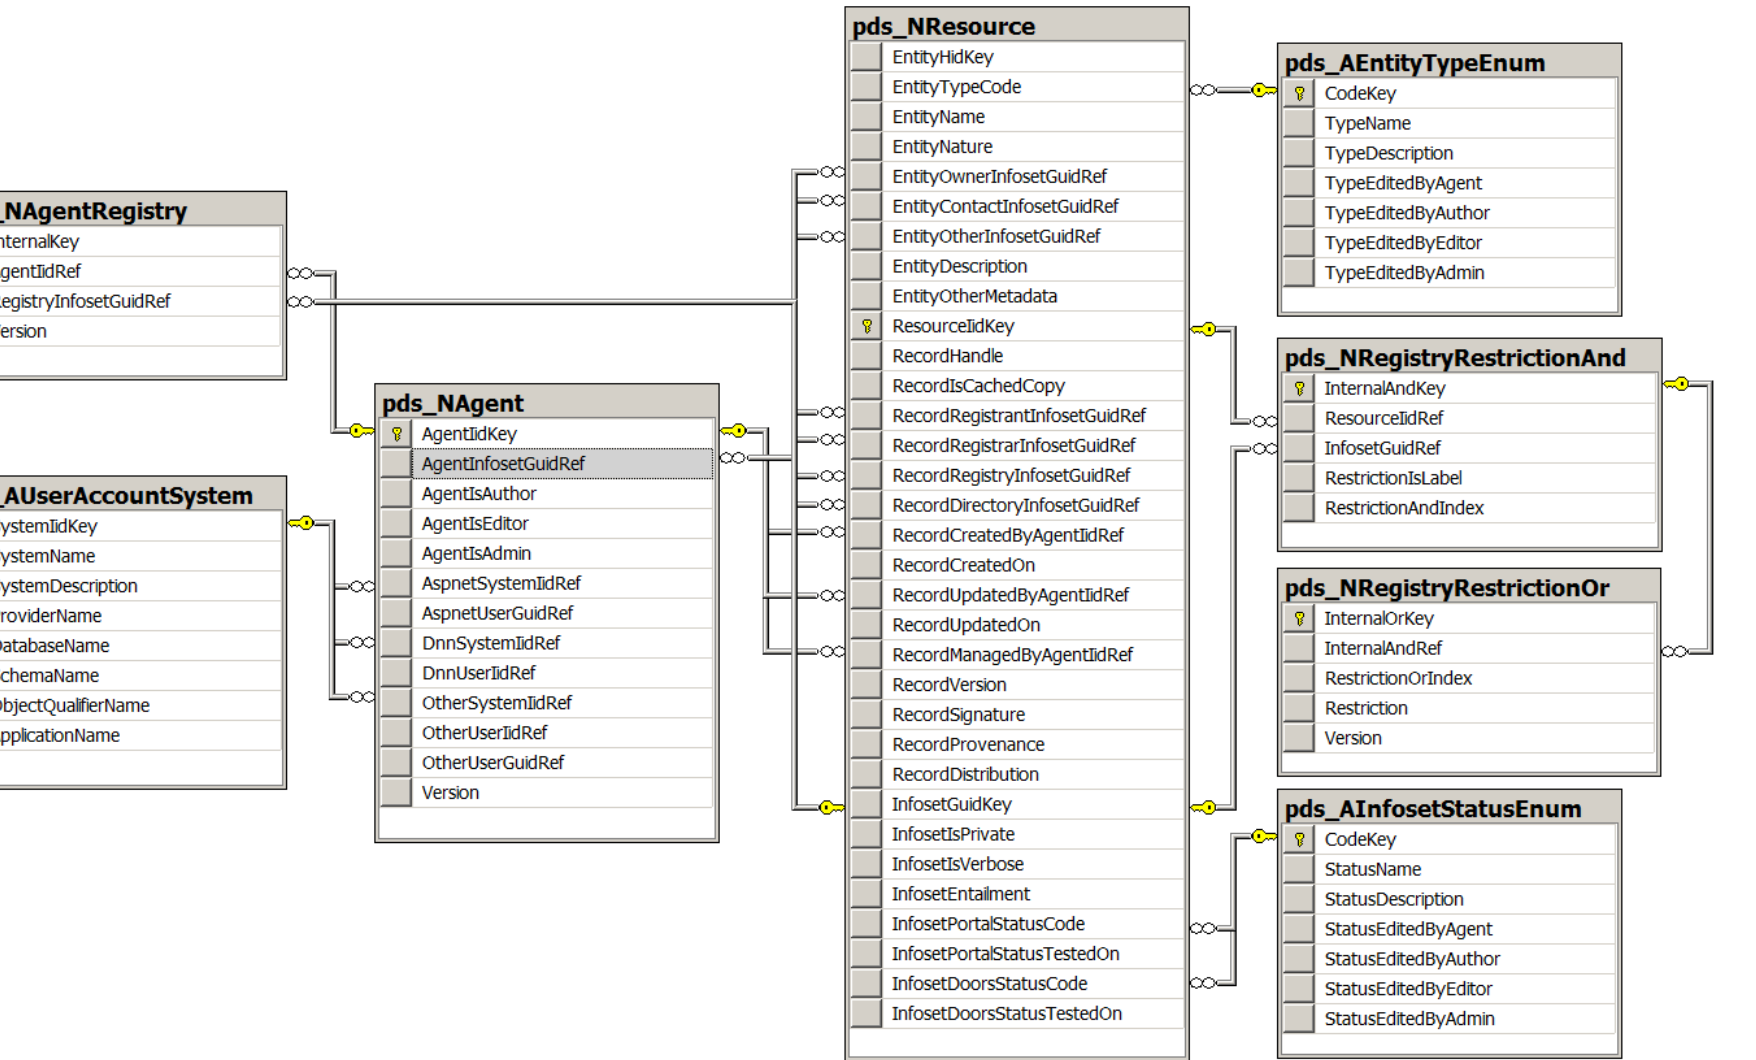
Figure 6. Relational database model for the auxiliary and administrative support tables for system and agent management in relation